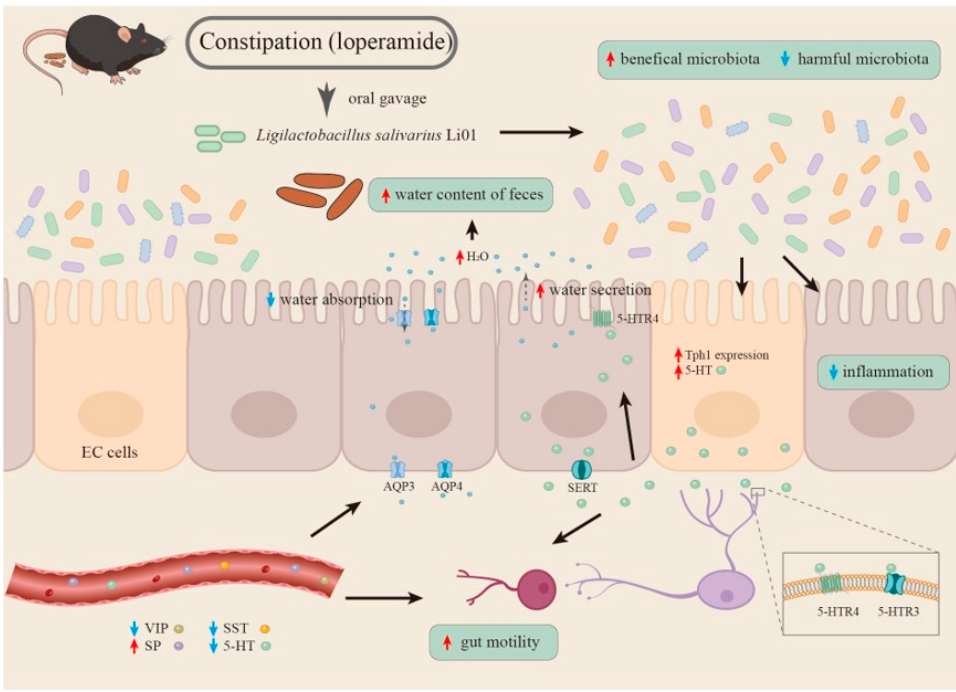
Figure 6. A summary of possible mechanisms by which Li01 can alleviate constipation symptoms.